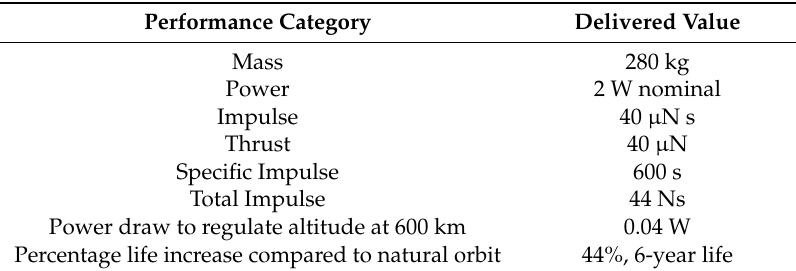
Table 26. PPTCUP Performance Specification